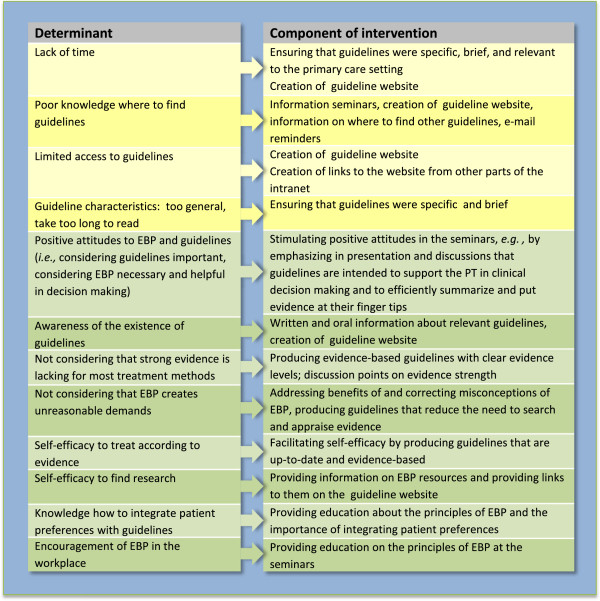
Matching determinants to intervention components. Most important barriers (yellow) and facilitators (green) of guideline use identified in previous cross-sectional survey
[5].